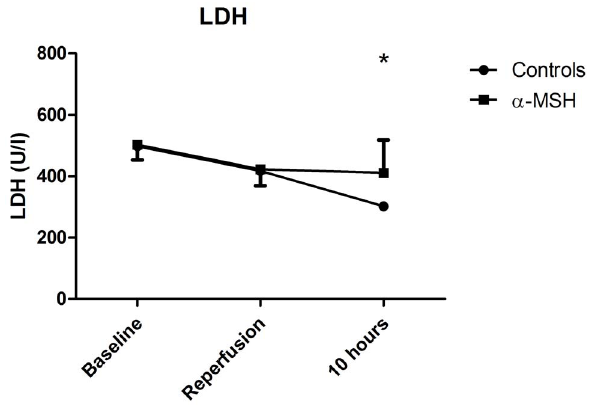
Figure 7. Effect of a -MSH on LDH. At ten hours post-reperfusion LDH was higher in a -MSH treated animals compared to controls (Figure 7; *=p , 0.05).